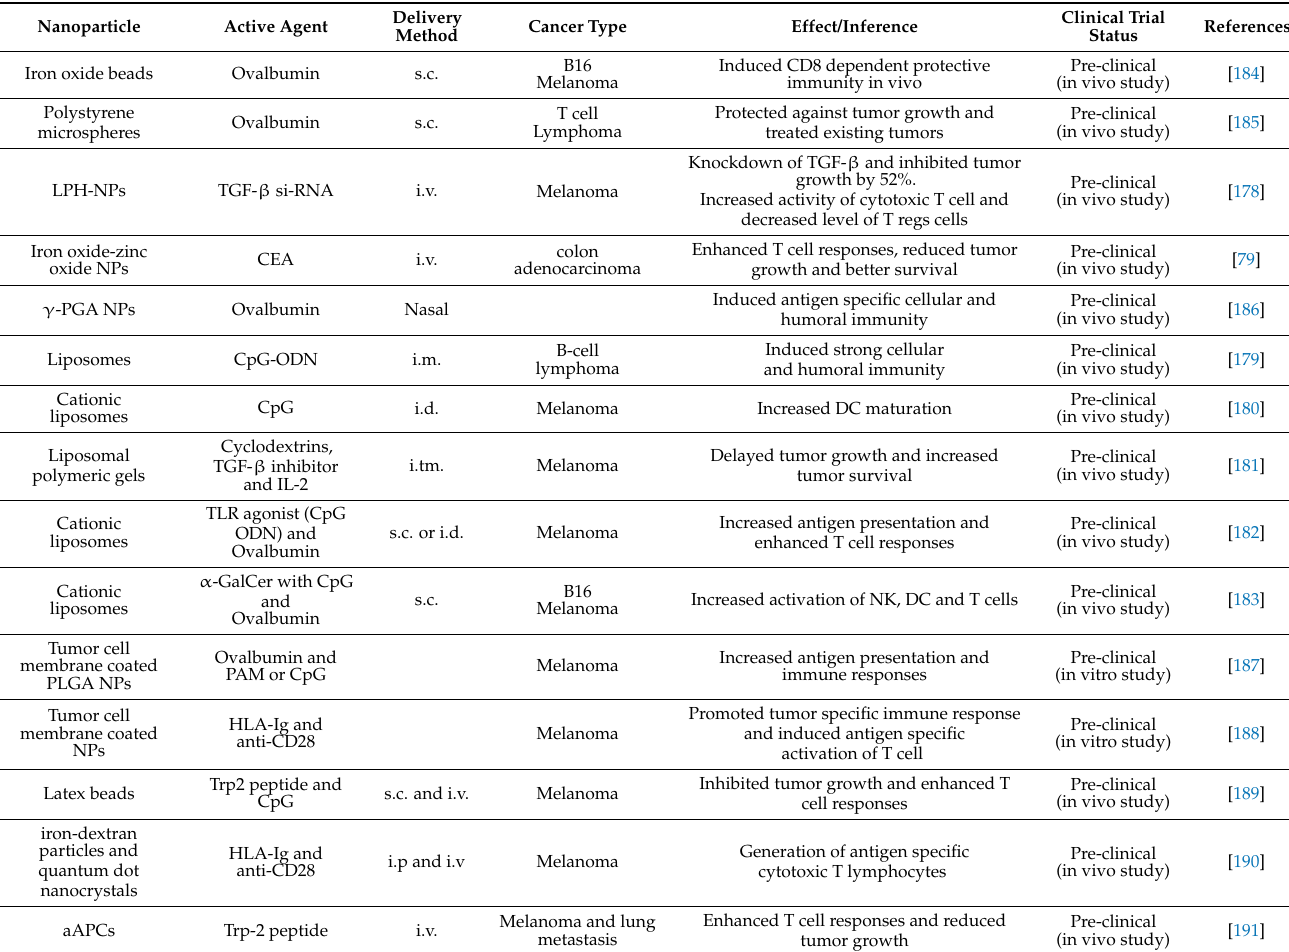
Table 3. Applications of Nanotechnology in Cancer